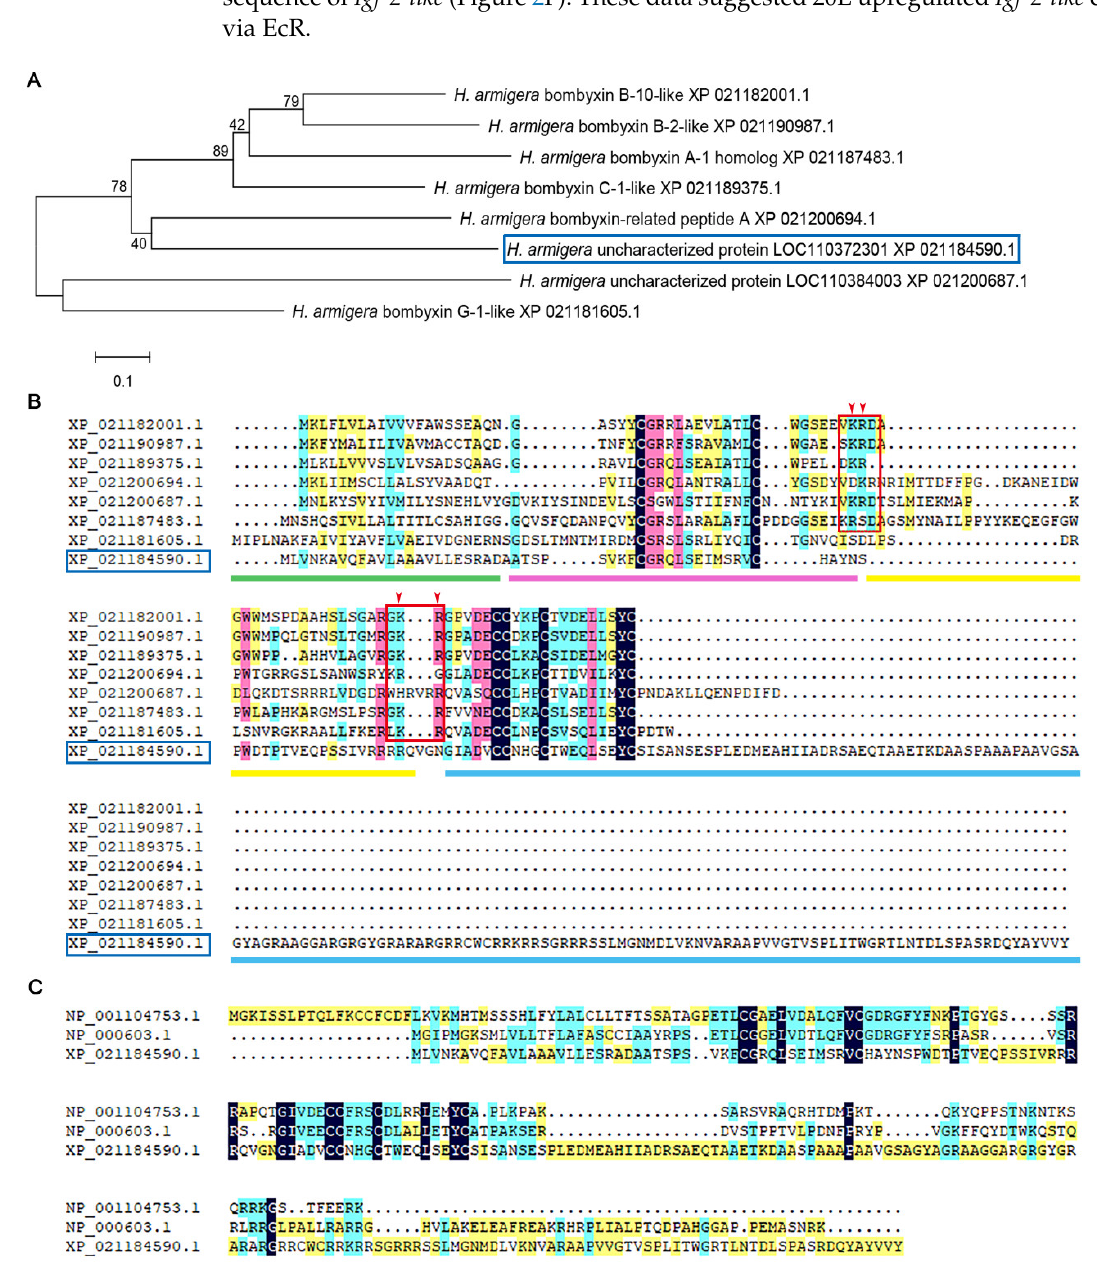
Figure 1. Identification of IGF-2-like of H. armigera . ( A ) A phylogenetic tree of ILPs in H. armigera analyzed by MAGE5. The blue box indicates IGF-2-like. ( B ) Sequence alignment of the ILPs of H. armigera . The red box marks the potential splicing sites (the double alkaline amino acids) at both ends of the C peptide. Green underline: signal peptide; pink underline: B chain; yellow underline: C peptide; blue underline: A chain. ( C ) Comparison of IGF-2-like with IGF-1 and IGF-2 of H. sapiens .